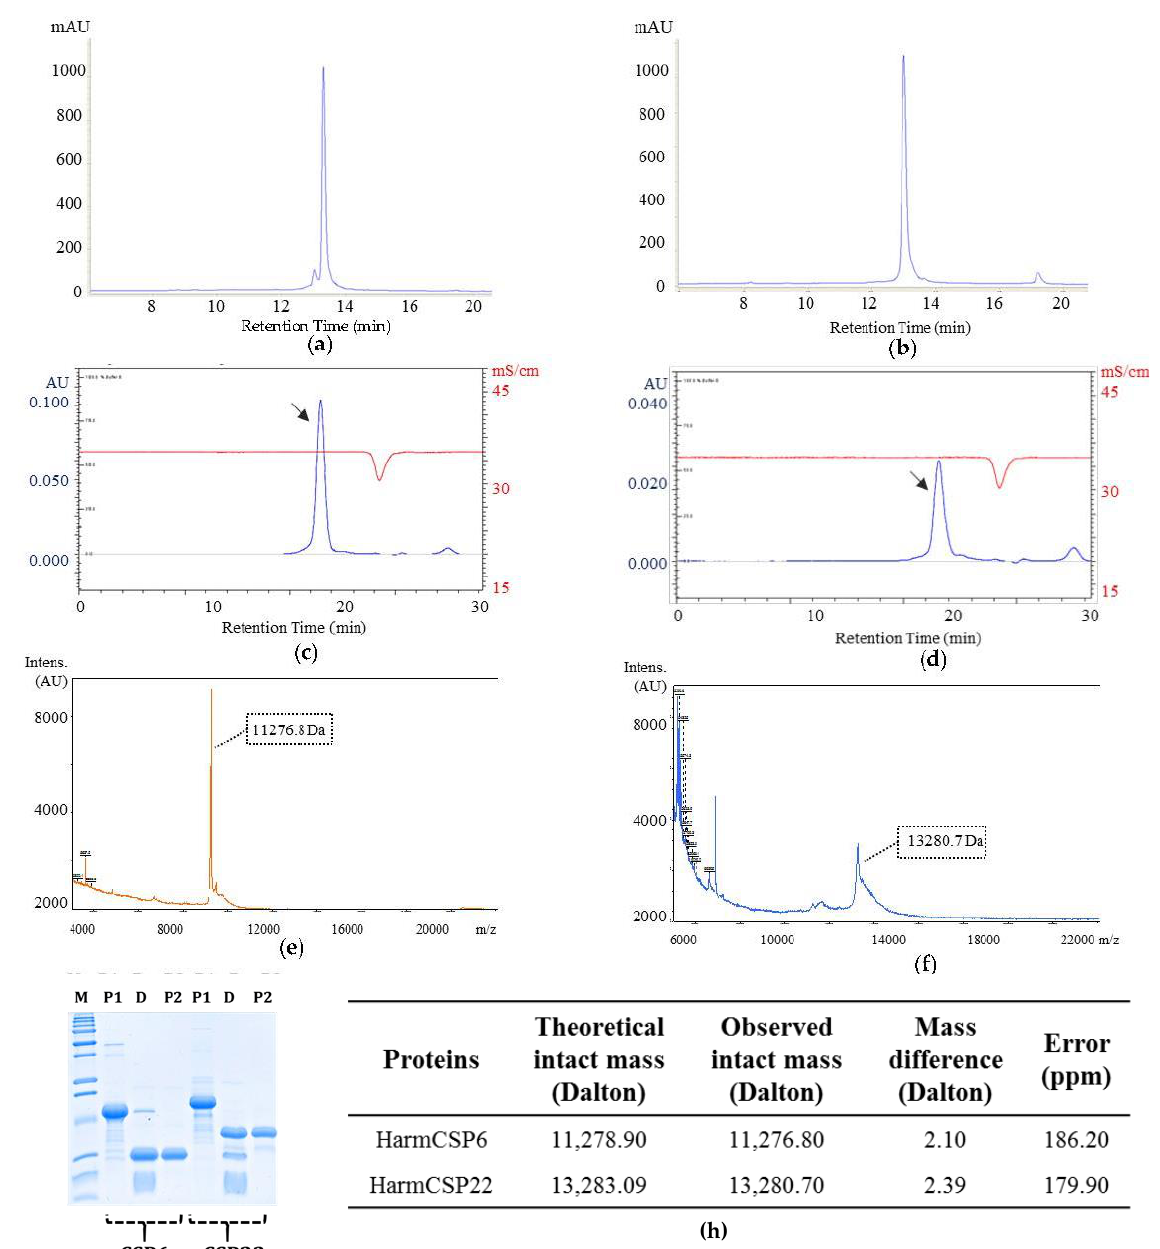
Figure 5. Purification and characterization of HarmCSP6 and 22. ( a , b ) RP-HPLC chromatogram of purified and digested HarmCSP6 and 22 showing >95% protein purity. ( c , d ) SE-FPLC chromatogram of purified and digested HarmCSP6 and 22 confirming the monomer nature (indicated by black arrow) of proteins; red line in both the chromatogram indicates conductivity. ( e , f ) MALDI-TOF intact mass profile of HarmCSP6 and 22. ( g ) SDS-PAGE gel image showing the Ni-NTA affinity chromatography of purified HarmCSP6 and 22. Lane 1 — marker, Lane 2 — first purification of HarmCSP6 (P1), Lane 3 — enterokinase digestion of HarmCSP6 (D), Lane 4 — second purification of HarmCSP6 (P2), Lane 5 — first purification of HarmCSP22 (P1), Lane 6 — enterokinase digestion of Harm-